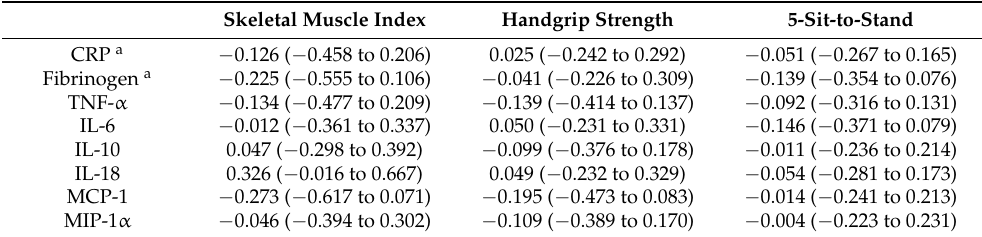
Table 3. Associations ( β -coefficients and 95% CI) between muscle health and pro- and anti- inflammatory biomarkers in older